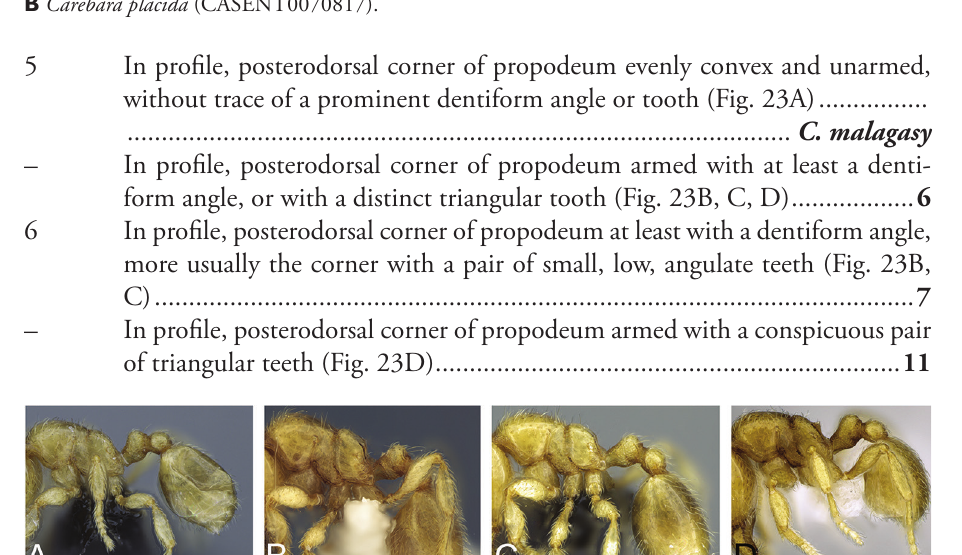
declining posteriorly (Fig. 24C, D, E, F) ....................................................